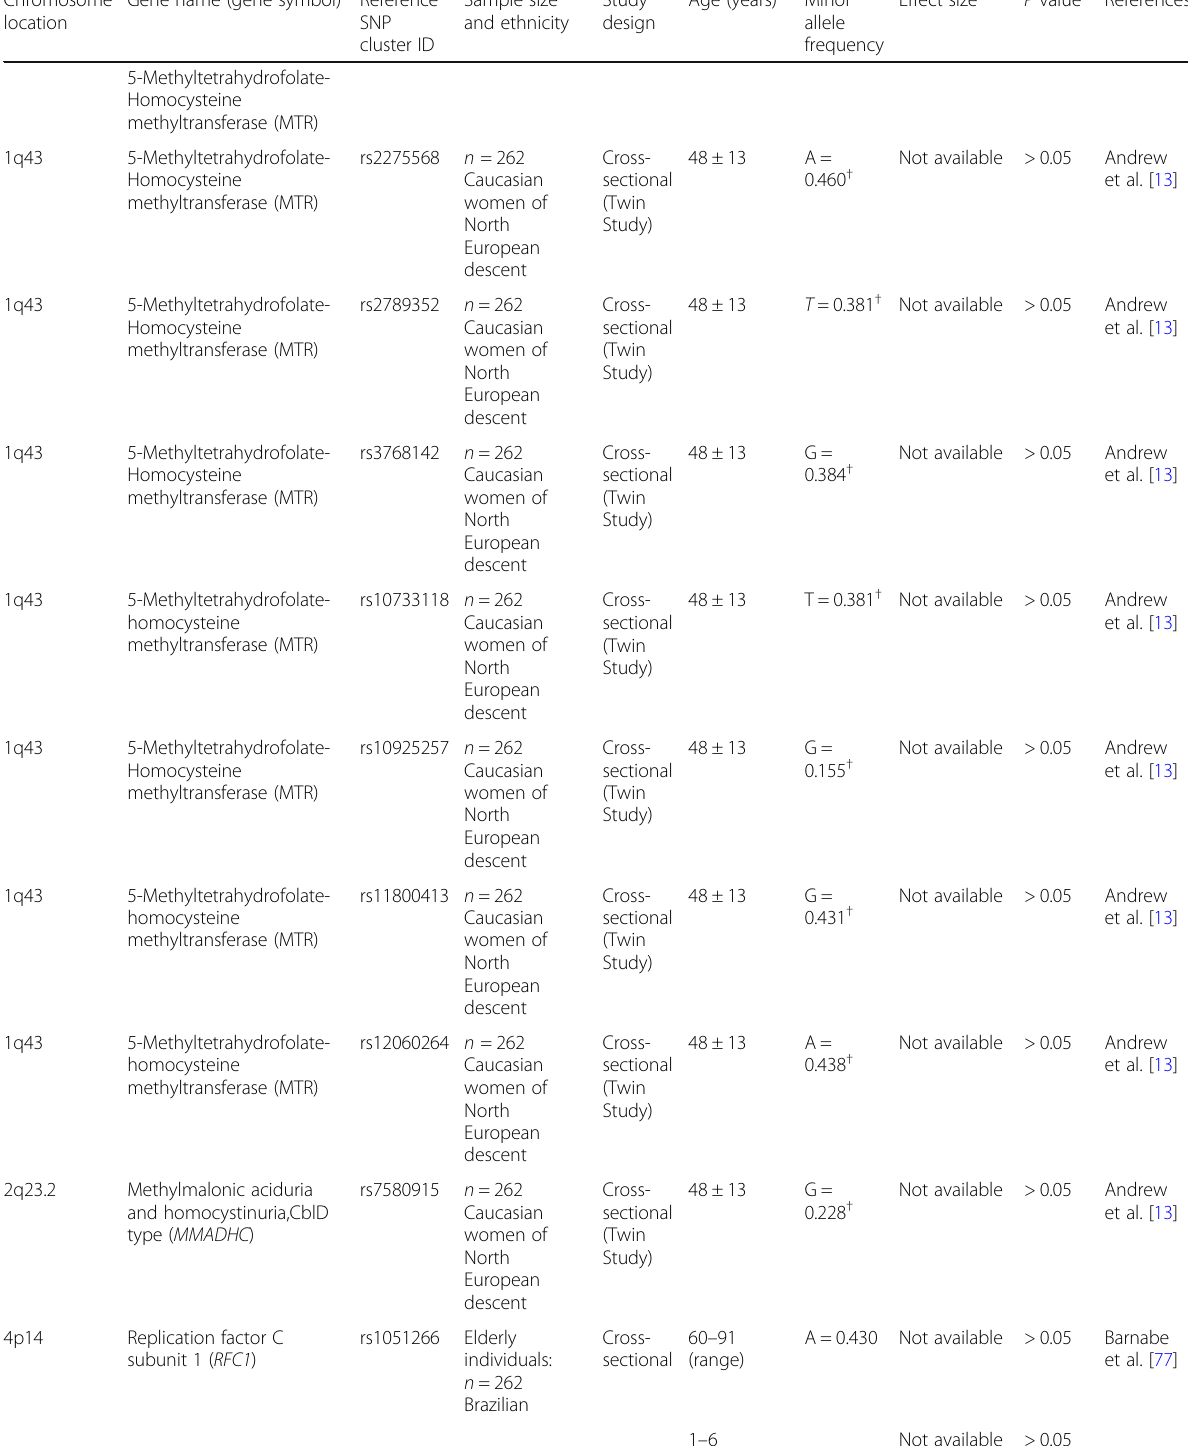
Table 2 Candidate gene association studies examining the association of SNPs with vitamin B12 concentrations. Candidate gene association studies testing the association between SNPs and vitamin B12 concentrations. The chromosome location, gene name, reference SNP cluster ID, sample size and ethnicity, study design, mean age, observed frequency of the minor allele in the population, effect size and P value are shown in the table. The order of SNPs reflects the order of the chromosome location